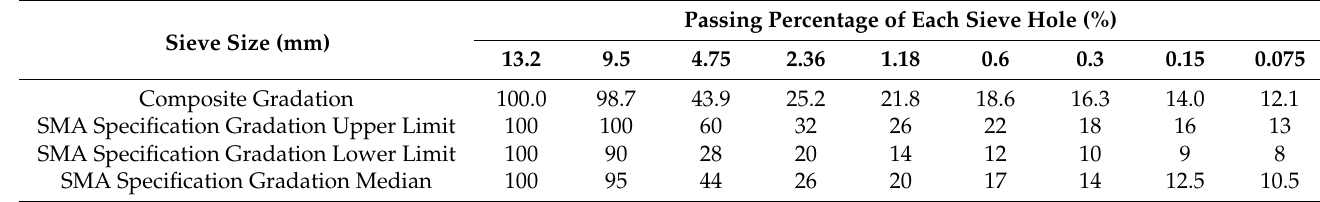
Table 5. SMA-10 Composite gradation.